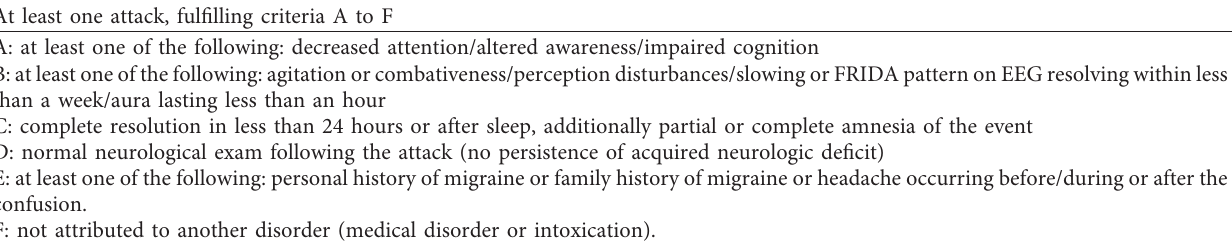
Table 2: Proposed criteria for the diagnosis of acute confusional migraine (By Farooqi et al. [9]). At least one attack, fulfilling criteria A to